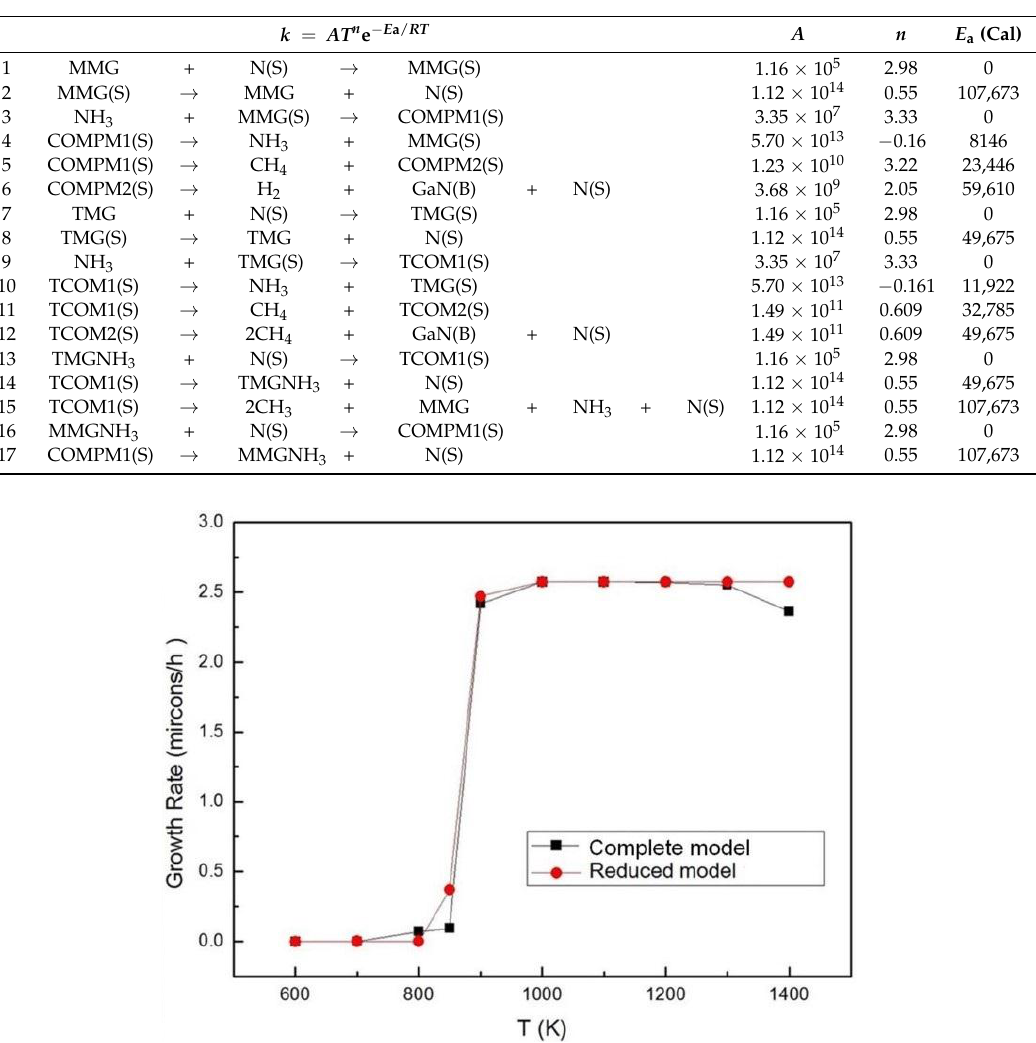
Table 5. Surface mechanisms (Path 1 + Path 3) are considered for the reduced model.